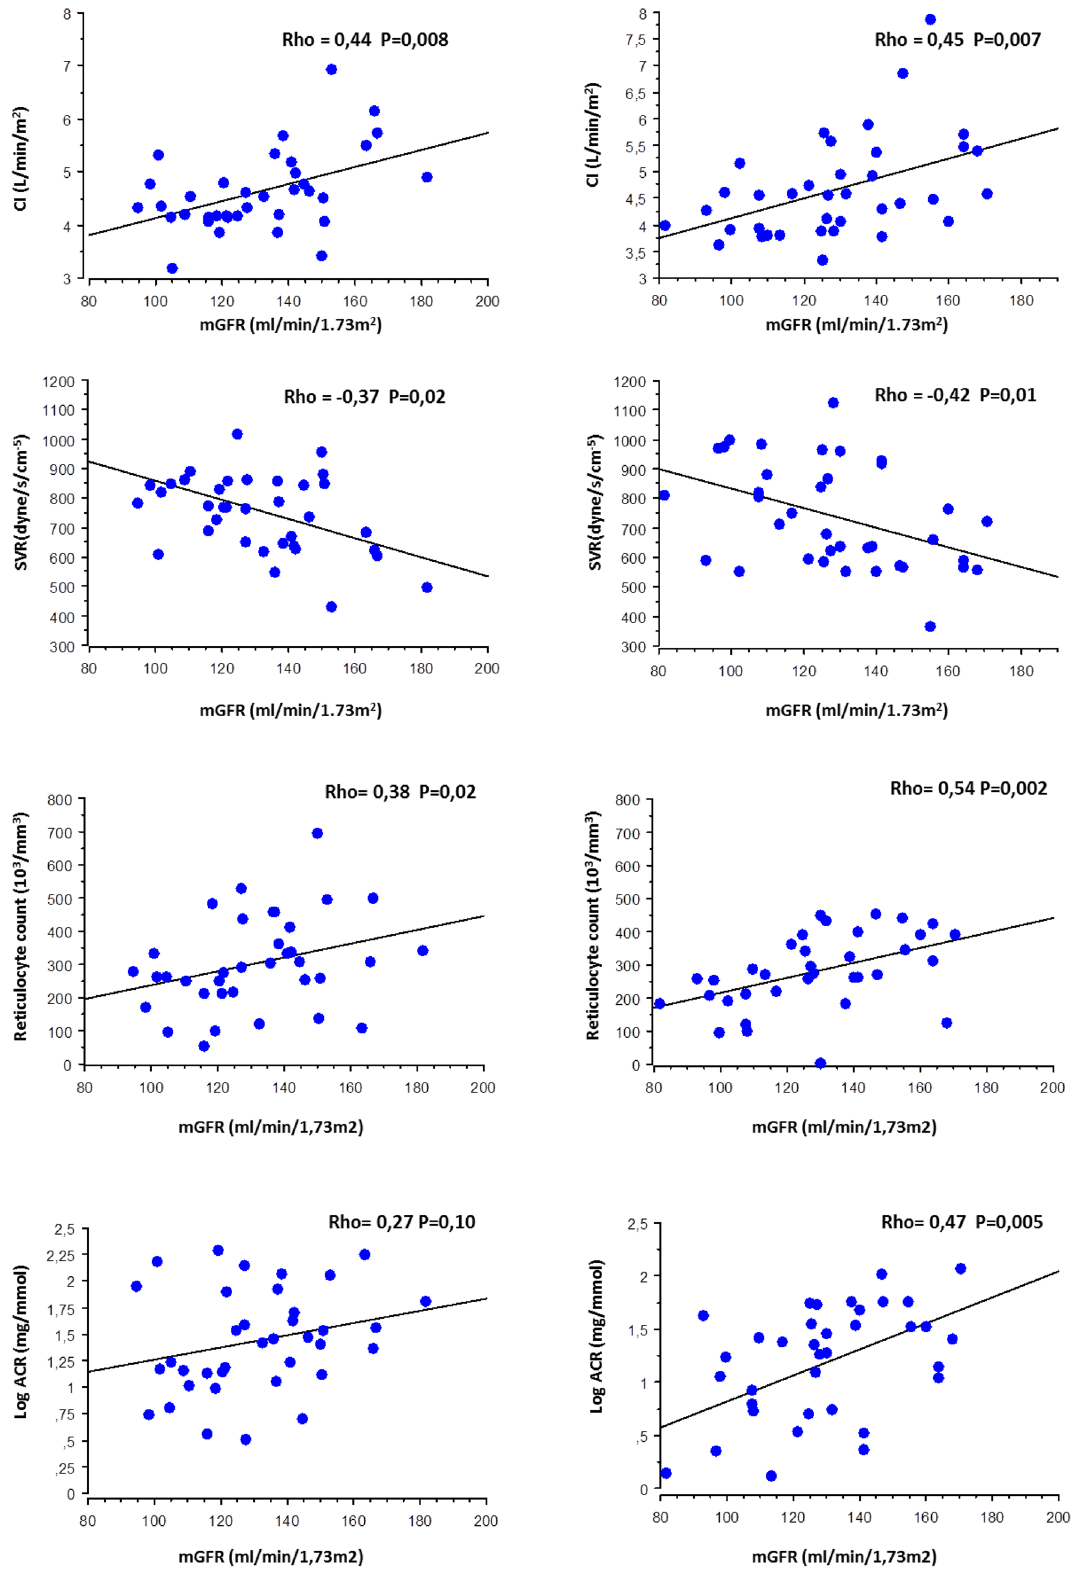
Figure 1. mGFR association with CI, SVR, reticulocyte count and ACR before and under ACEI treatment. CI: cardiac index; SVR: systemic vascular resistance; ACR: albumin creatinine